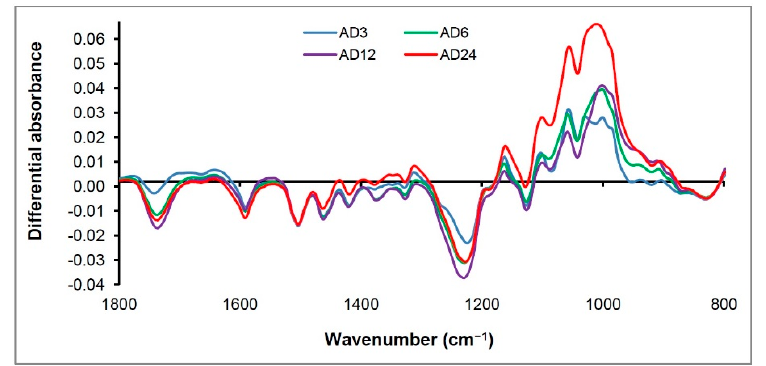
Figure 15. Differential FTIR spectra of poplar wood samples. Forests 2018 , 9 , x FOR PEER REVIEW